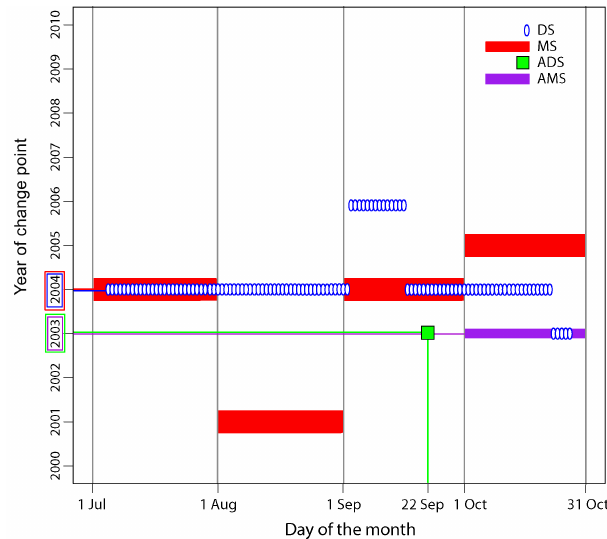
Figure 7. Summary of the identified change points (CPs) in means identified using the AMOC method with the four series of ice extent anomalies for the whole Arctic (DS, MS, ADS, and AMS) from 1980 to 2016. The blue points refer to the change points in DS; the red lines portray change points in the MS (July–October). The green square corresponds to the change point in the ADS, and the purple line represents the change point in the